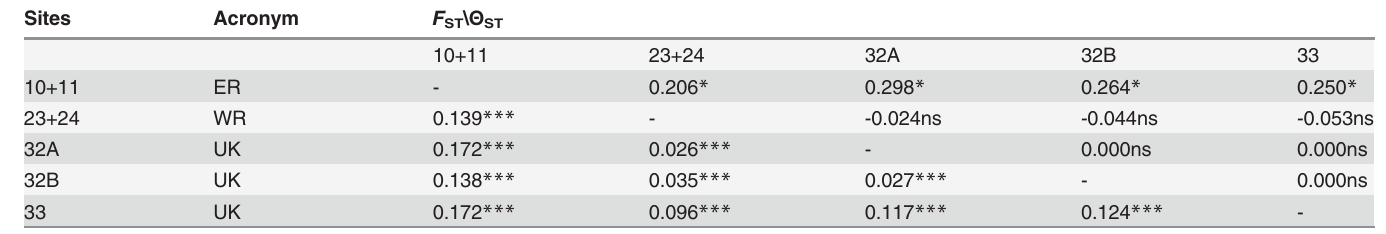
Table 4. Genetic pairwise differentiation estimated for microsatellites ( F ST , below diagonal) or mitochondrial DNA ( Θ ST , above the diagonal) between sites or group of sites in the possible source populations for UK and UK